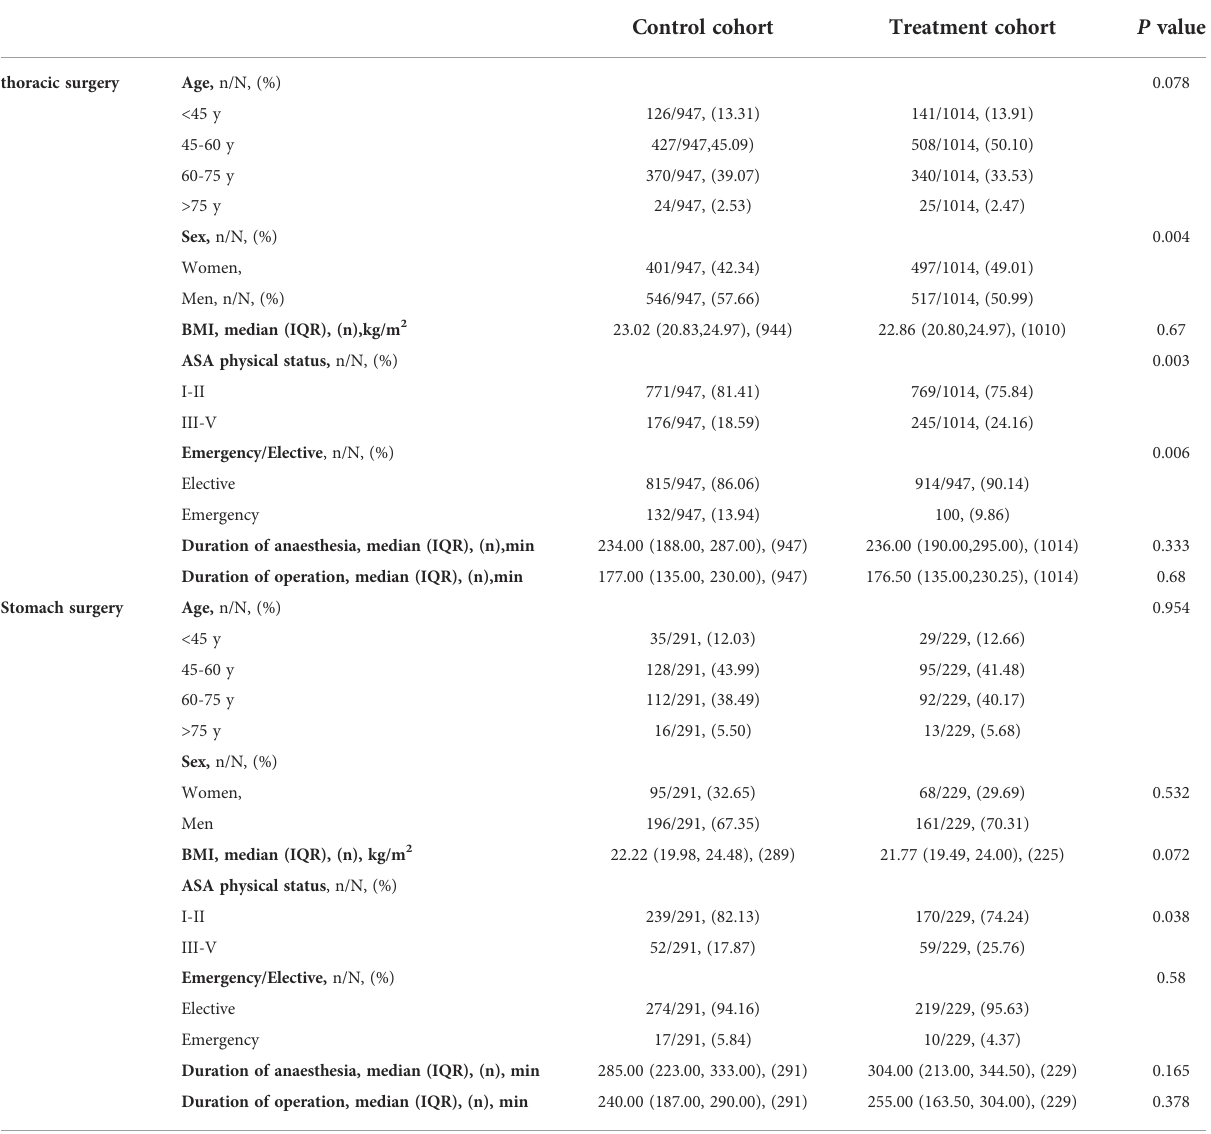
TABLE 1 Patient Characteristics In the Control and Treatment